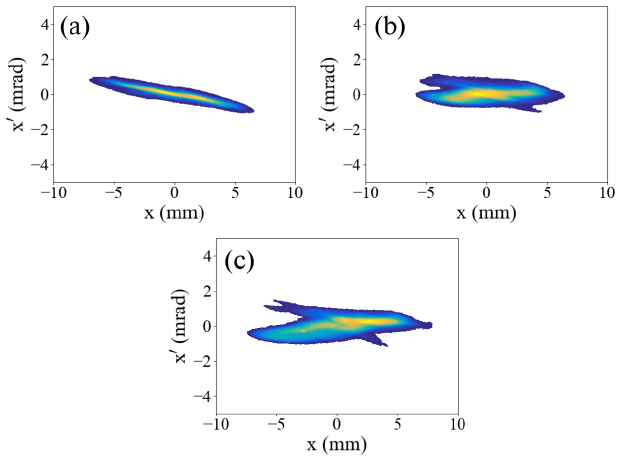
FIG. 9. Experimentally measured phase spaces with different launching phases. Single slicing is used with the projection method to measure the phase space. All machine parameters are fixed, while the launching phase is varied to 30°, 50°, and